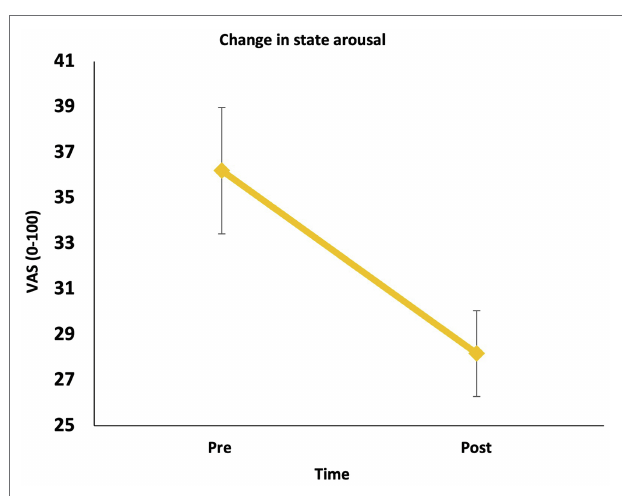
FIGURE 2 | Change in state hyperarousal (pre to